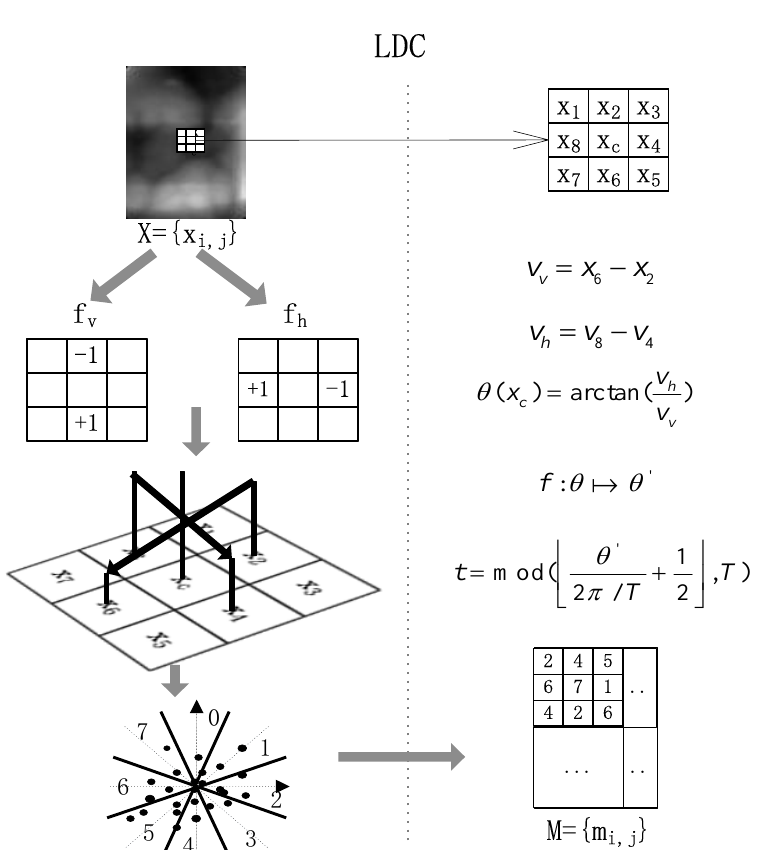
Figure 1. Description of the calculation of the LDC